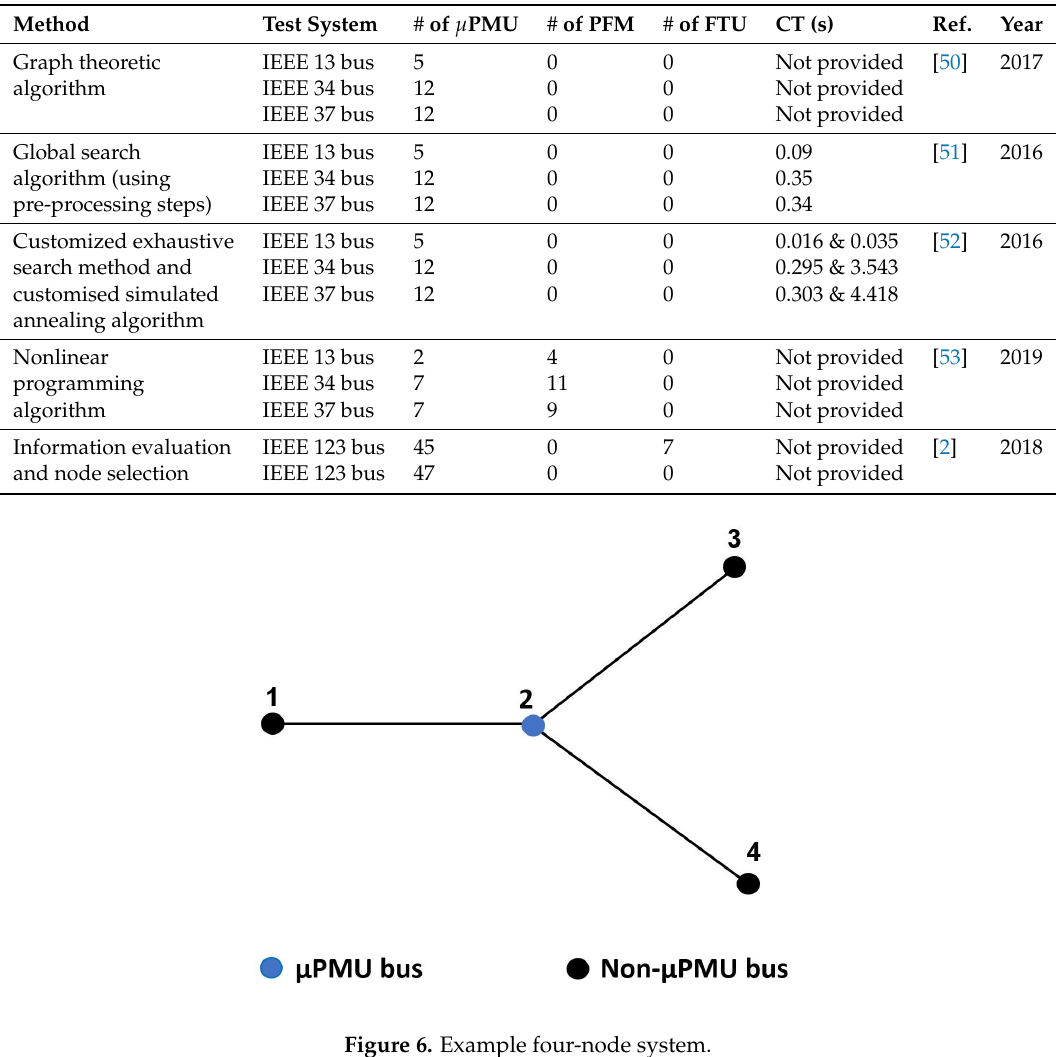
Table 4. Performance comparison of the methods that have been used for optimal µ PMU placement in the distribution networks. PFM: Power Flow Measurement; FTU: Feeder Terminal Unit; CT: Computational Time.